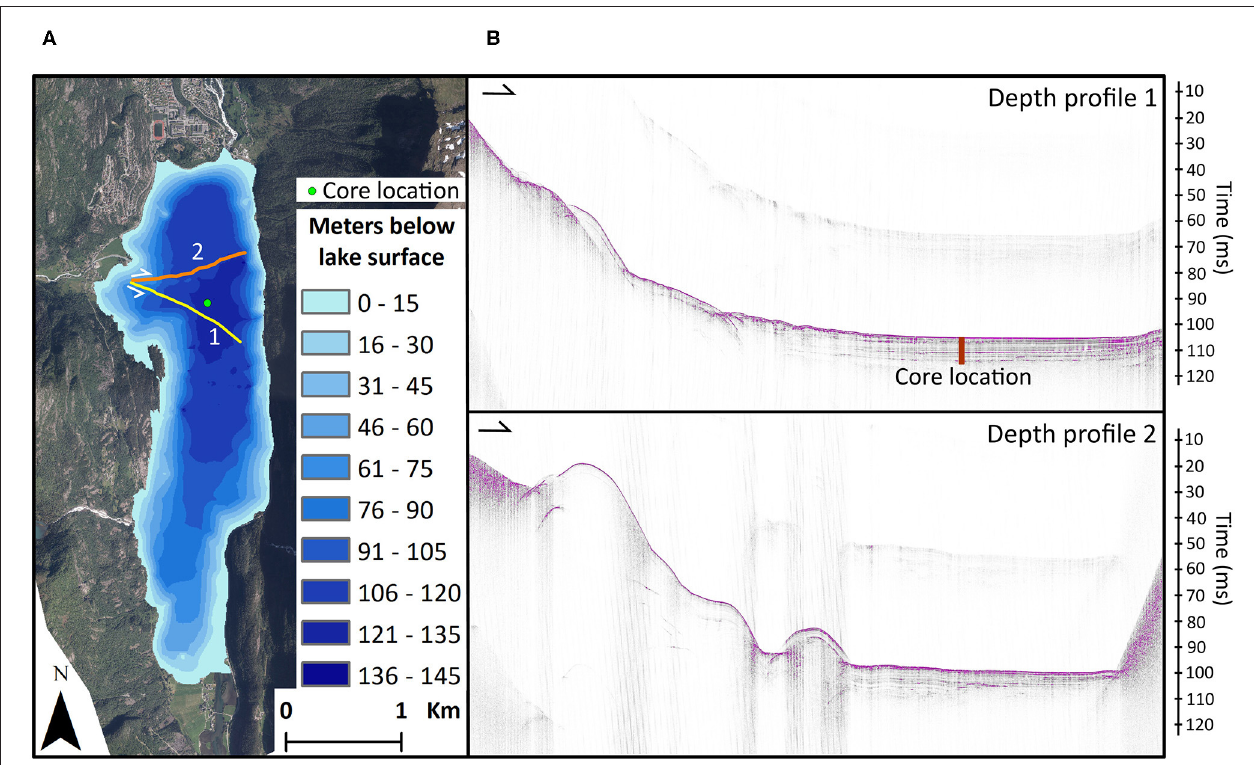
FIGURE 3 | (A) Map over Sandvinvatnet and the bathymetry based on eco sounding measurements. The coring site is marked with a green dot. The orange and yellow lines show the location of the two seismic profiles shown in (B) . (B) Two seismic profiles derived using a chirp starting at the delta front and ending close to the steep slope in the east. Profile 1 is close to the core location (indicated, not to scale, in depth profile 1). The depth at the coring site is close to